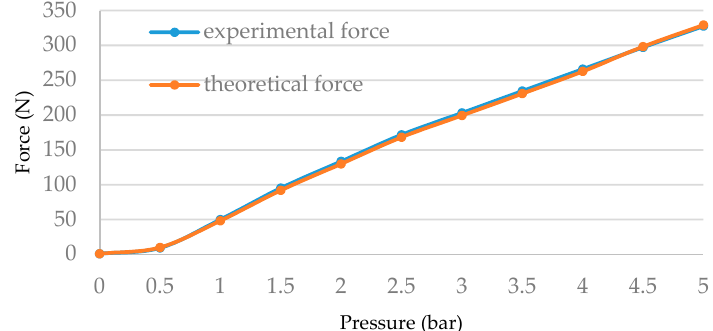
Figure 9. The experimental and theoretical force of the PMA against air pressure.